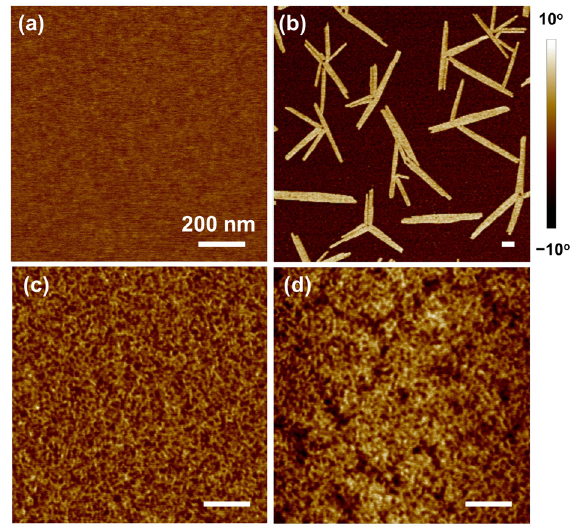
Figure 5. AFM phase images of the films cast from the DMSO solution of PVDF/GAP blend (weight percentage of GAP = 10%): ( a ) as-cast film; ( b ) film was annealed with saturated DMSO vapor for 2 h; ( c ) film was crosslinked via UV-irradiation (254 nm, 2 h) and then ( d ) annealed with saturated DMSO vapor for 2 h.